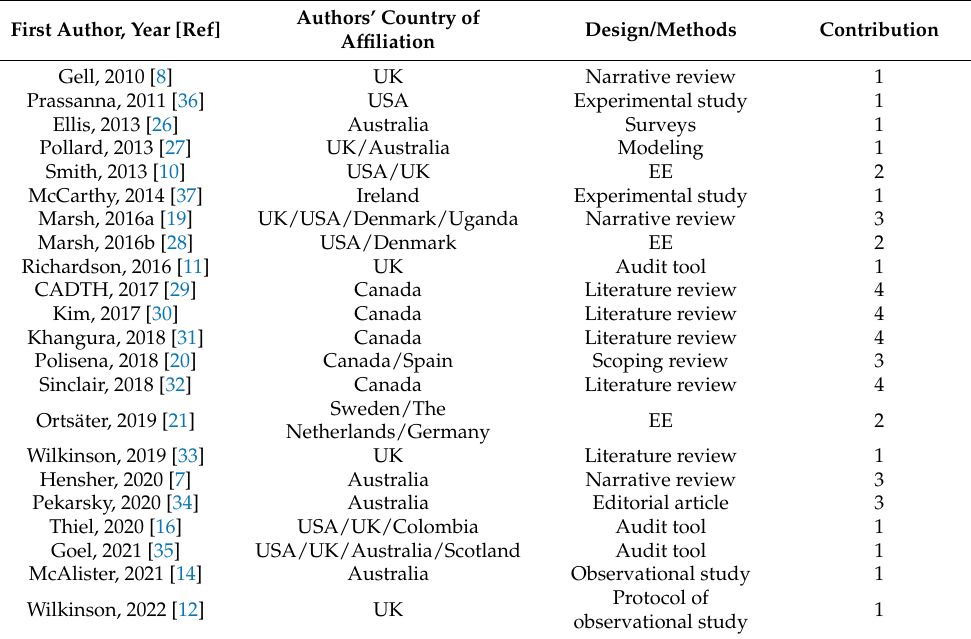
Table 1. Main characteristics of the included studies and contribution to this